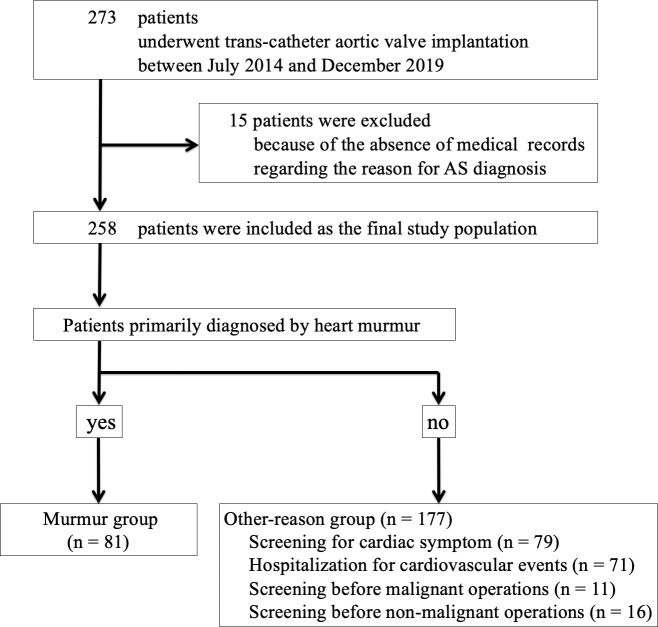
Study flowchart.AS, aortic valve stenosis.